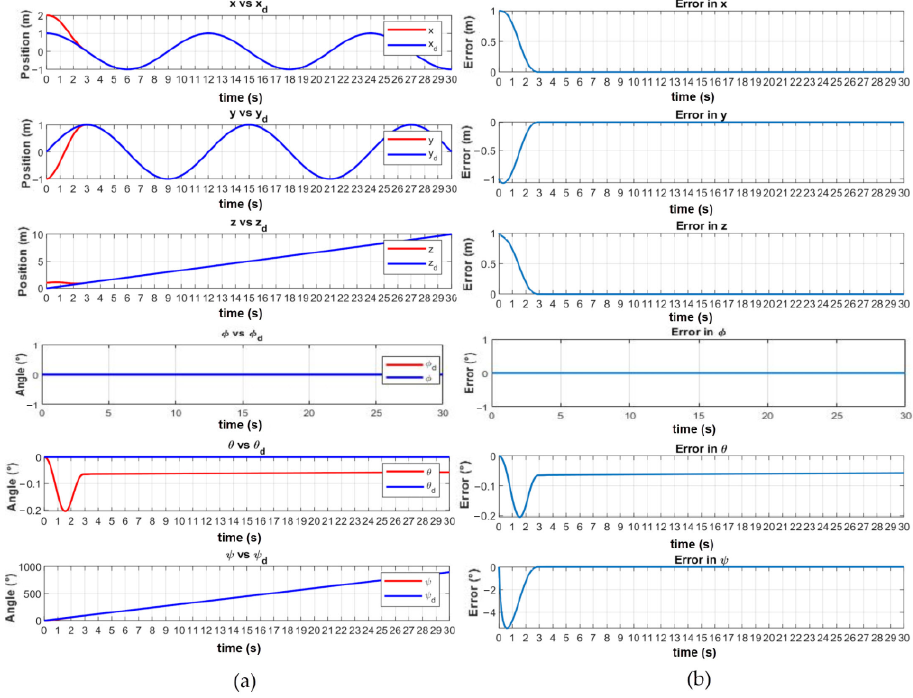
Figure 8. Results with t b = 3 s. ( a ) Trajectory tracking. ( b ) Position tracking errors.